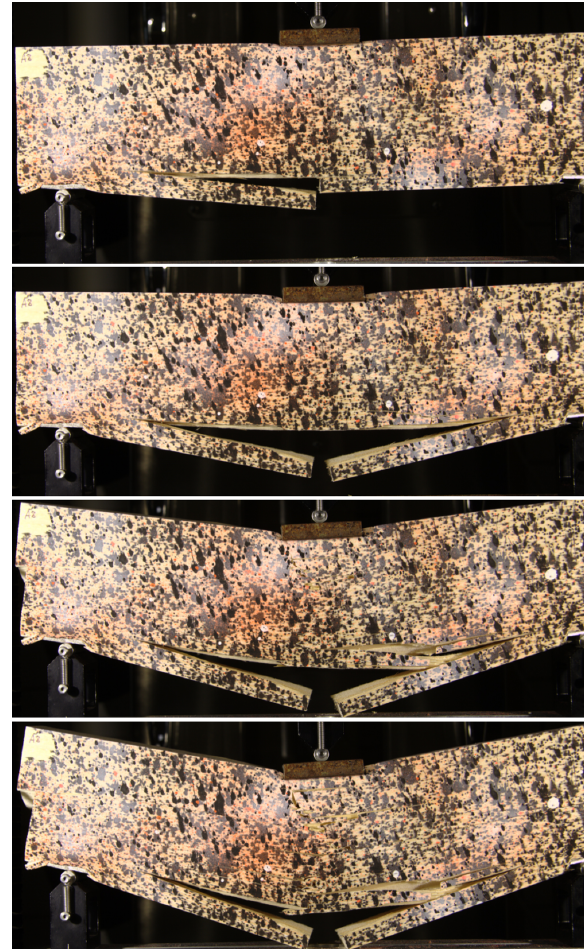
Figure 16. Damage evolution of the beam #14 with failure F3 - parallel with the grain followed by splinter above the notch and shear failure.